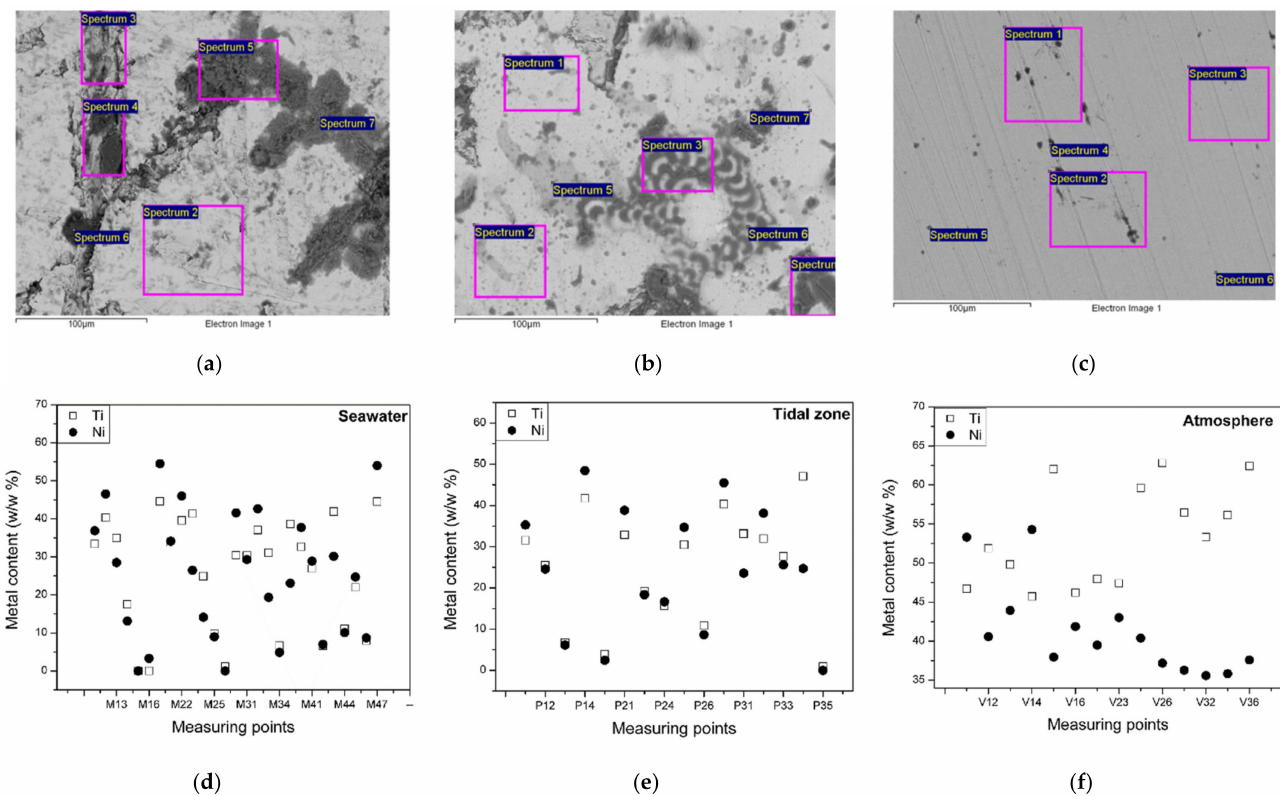
Figure 9. The representative micrographs of the NiTi discs with the corresponding metal content results after 6 months of exposure: ( a , d ) in seawater; ( b , e ) in a tidal zone; ( c , f ) in